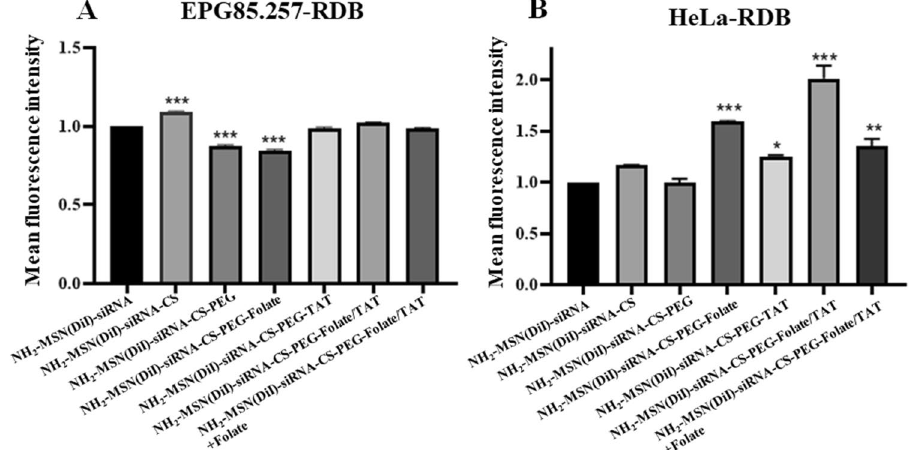
Figure 6. Assessment of the cell uptake efficiencies of various nanoparticles. Flow cytometry analysis in EPG85.257-RDB and HeLa-RDB indicated the successful intracellular uptake of functionalized chitosan-coated NH 2 -MSNs in HeLa-RDB cells. Symbols (*), (**) and (***) denote significant differences between the control (naked NH 2 -MSNs) and coated samples by p < 0.05, p < 0.01 and p < 0.001. MFI Mean fluorescence intensity, CS chitosan, PEG polyethylene glycol, TAT trans-activator of